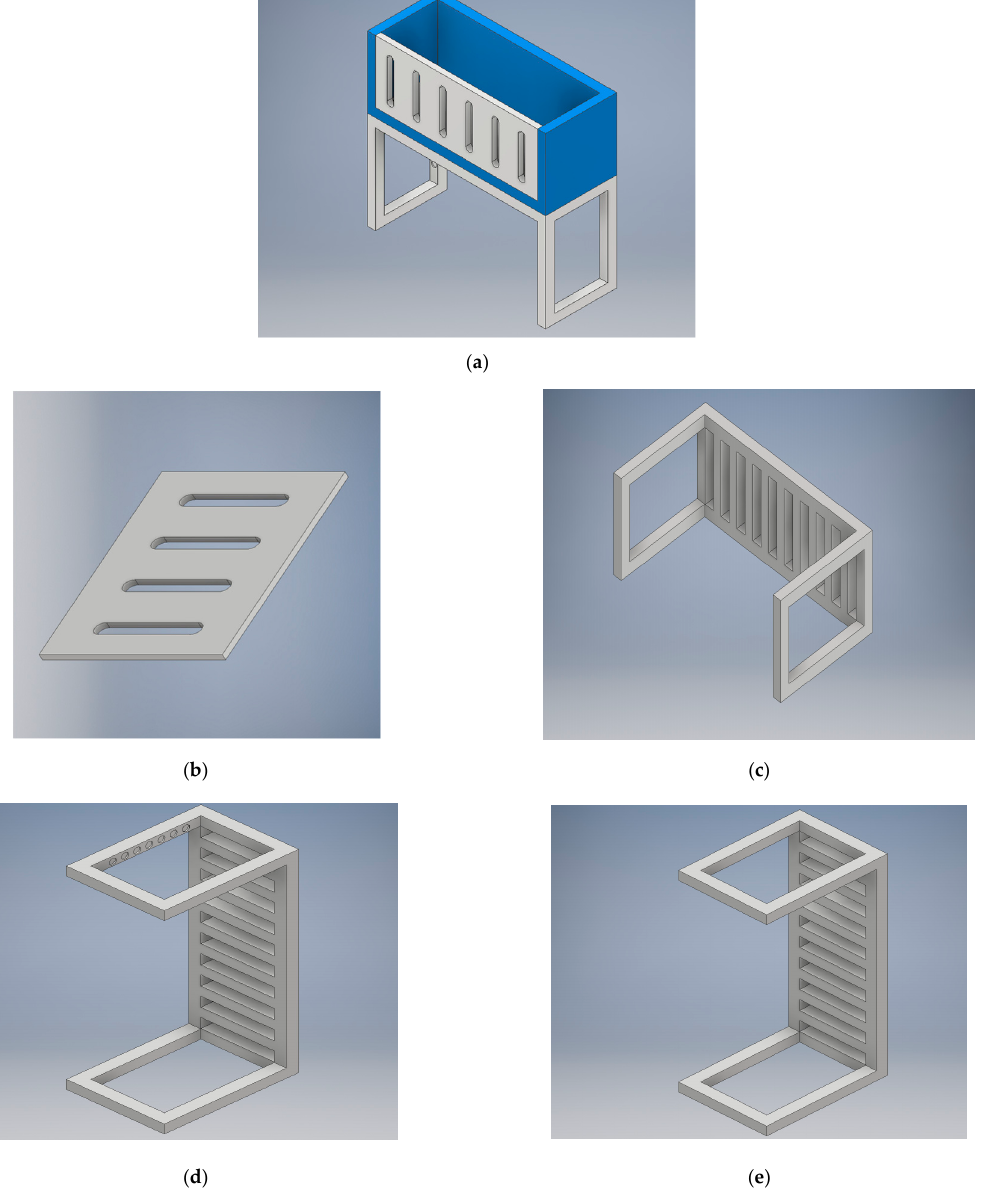
Figure 5. Repurposed parts of concept 4. ( a ) Crib design. ( b ) Ramp design. ( c ) Bicycle stand design. ( d ) Outdoor shower structure. ( e ) Exercise equipment structure.